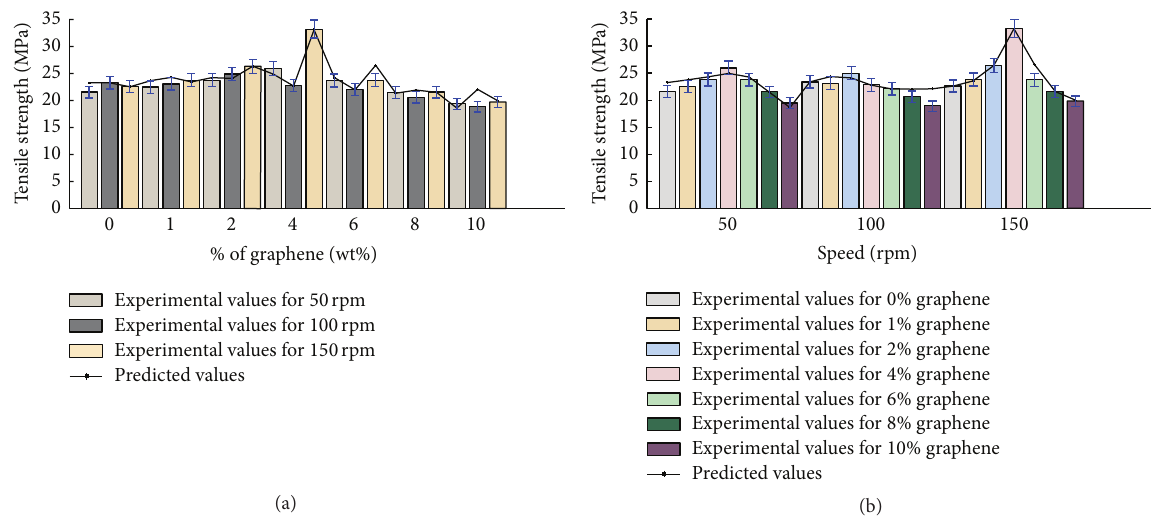
Figure 14: (a) Experimental versus predicted values of tensile strength of LLDPE/GNPs composites as a function of % of graphene. (b) Experimental versus predicted values of tensile strength of LLDPE/GNPs composites as a function of speed.